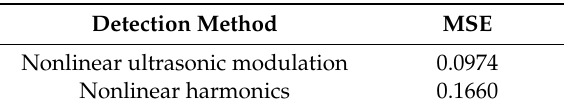
Table 1. MSE of nonlinear ultrasonic modulation and nonlinear harmonics.